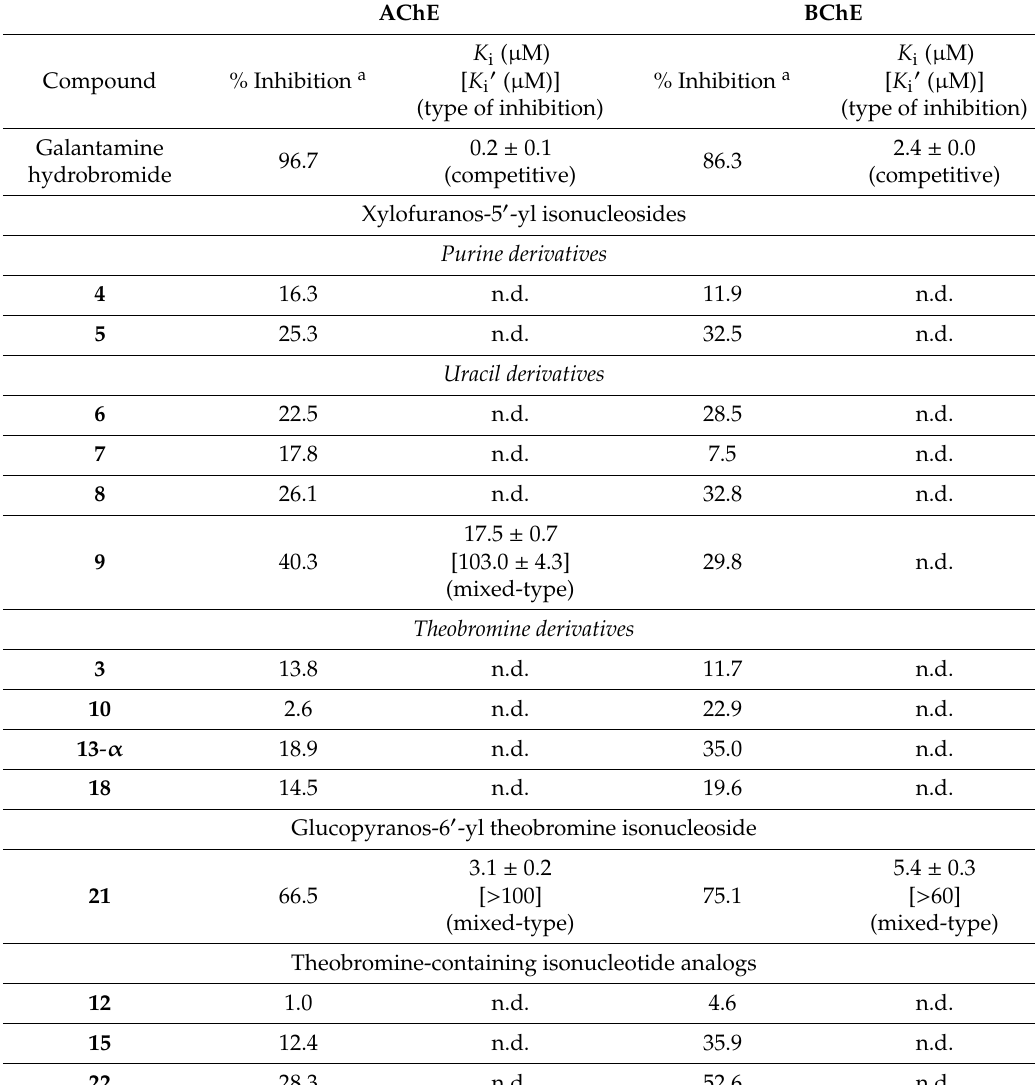
Table 1. Results of the evaluation of the inhibitory activities of the compounds on cholinesterases. Compound % Inhibition a Galantamine hydrobromide